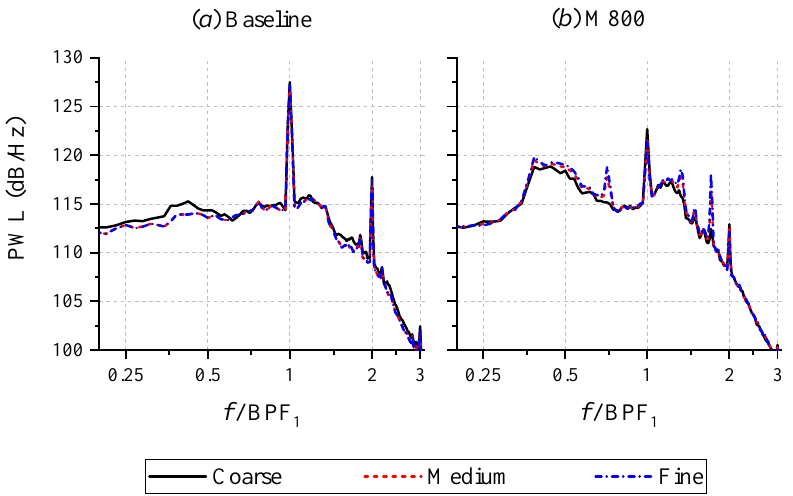
Figure 6. The variation of the sound power level (PWL) of the SDT fan stage against the grid resolution